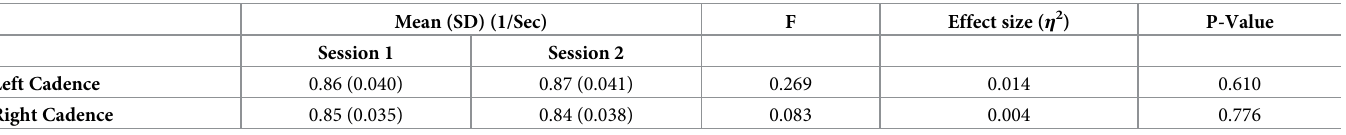
Table 4. Detailed statistical results for push frequency (cadence) for the left and right